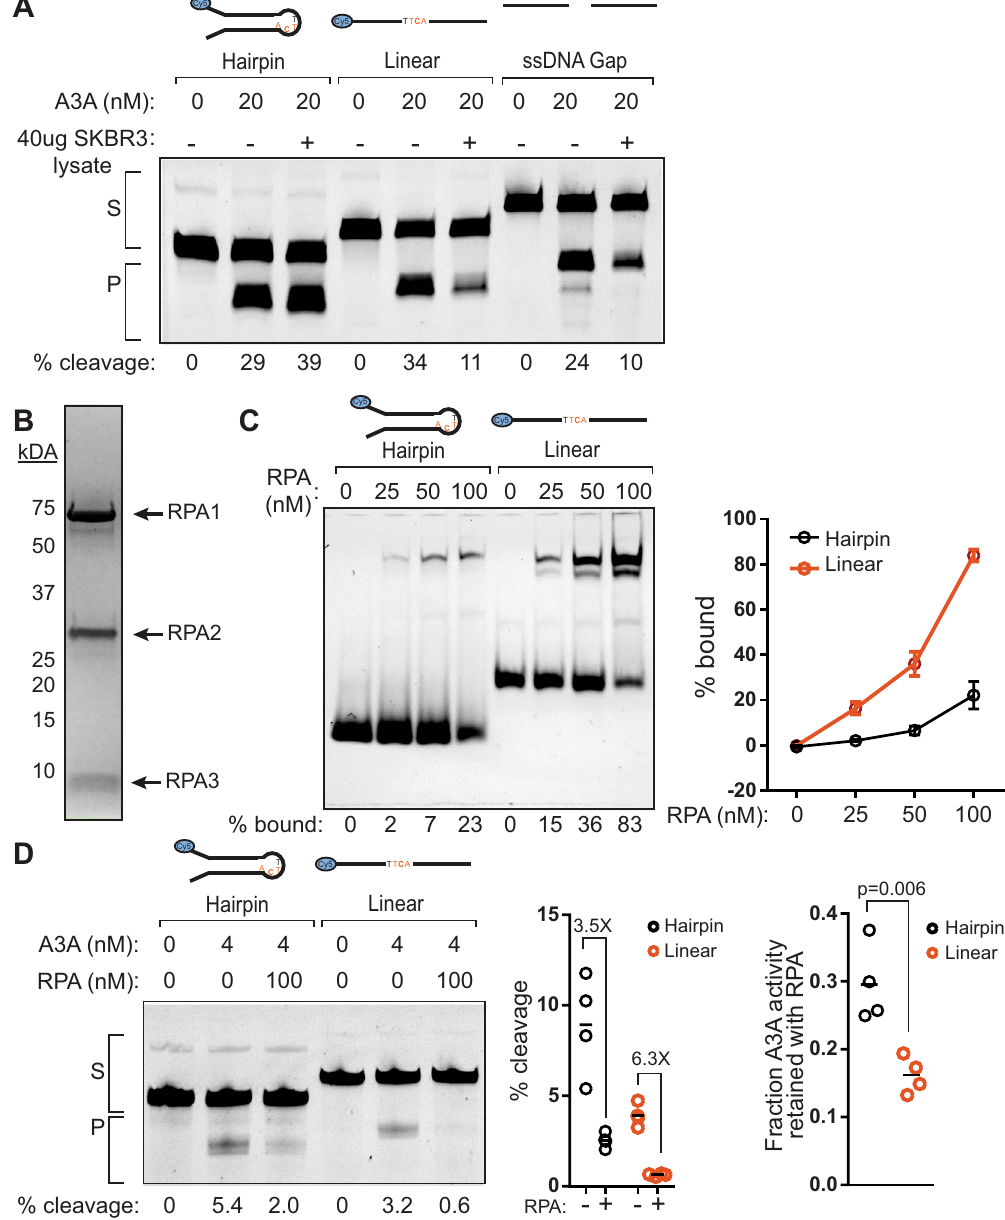
Figure 4. APOBEC3A activity is reduced more severely on linear substrates than on hairpins in the presence of whole cell lysate or RPA. ( A ) Deaminase assay of 20 nM A3A or no A3A incubated with 20 nM hairpin, linear, or gap-fill substrates with or without whole cell lysate. Substrates were preincubated with 40 µg of SKBR3 whole cell lysates or buffer for 1 h at 37 °C, then A3A was added to 20 nM final concentration, and incubated for an additional 30 min at 37 °C prior to processing as in Fig. 1C. S denotes the substrate band; P denotes the product band. The results are representative of three independent experiments. ( B ) Coomassie stained SDS-PAGE gel of purified human RPA. ( C ) Electrophoretic mobility shift assay of 0, 25, 50, and 100 nM RPA incubated with 50 nM hairpin or linear ssDNA substrate. Three replicate experiments were quantified to determine the percent of each substrate bound. Dots and error bars indicate mean values and standard deviation. ( D ) 4 nM A3A was incubated with 50 nM hairpin or linear ssDNA substrate at 37 °C for 5 or 15 min, respectively, in the presence or absence of 100 nM RPA. The percent substrate cleavage in the presence and absence of 100 nM RPA as well as the fraction of A3A deaminase activity remaining after RPA addition for the hairpin (black dots) and linear substrates (red dots) was quantified from 4 experimental replicates. Horizonal bars indicate mean values. P-values were determined by t-test. Full-length gel images for 4A and 4D are presented in Fig.